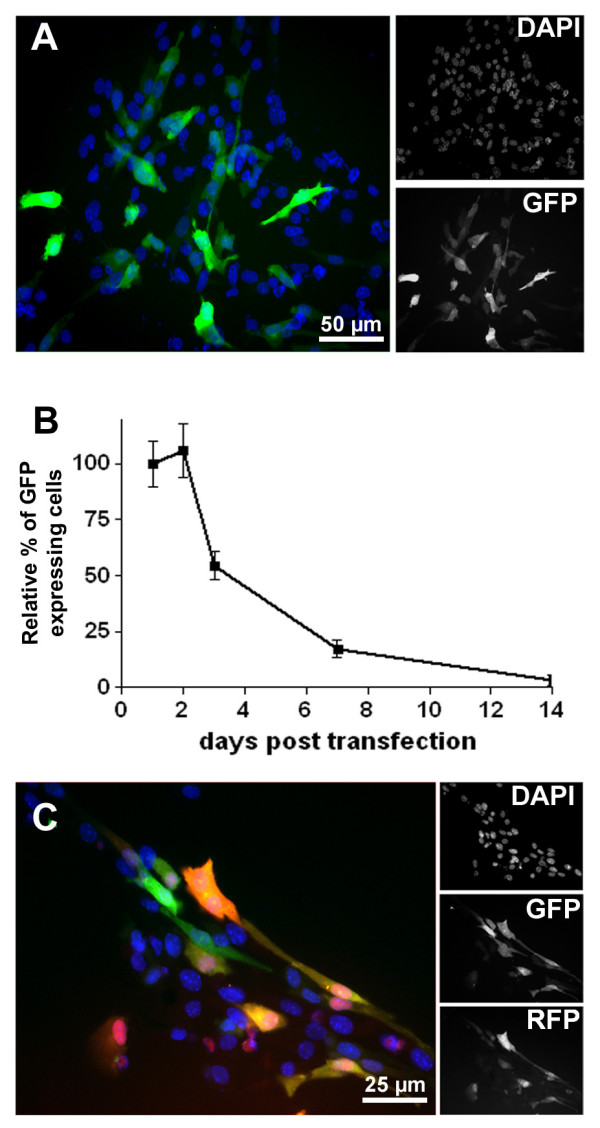
Efficient nucleofection of single/multiple plasmids in mouse spinal cord NPCs. A: Strong expression of the green fluorescent protein (GFP) coded by the control pMax plasmid (2 μg) was observed in ~30% of the cells at 48 h after transfection. B: Time course of GFP expression revealed a fast but transient expression of the reporter gene. C: Cotransfection with pMax (2 μg) and RFP (2 μg). Due to a weaker expression, RFP could only be detected in a subpopulation of GFP expressing cells. However, almost all RFP expressing cells were GFP positive (95% ± 3) demonstrating efficient and reliable plasmid co-transfection coul be achieved by nucleofection.